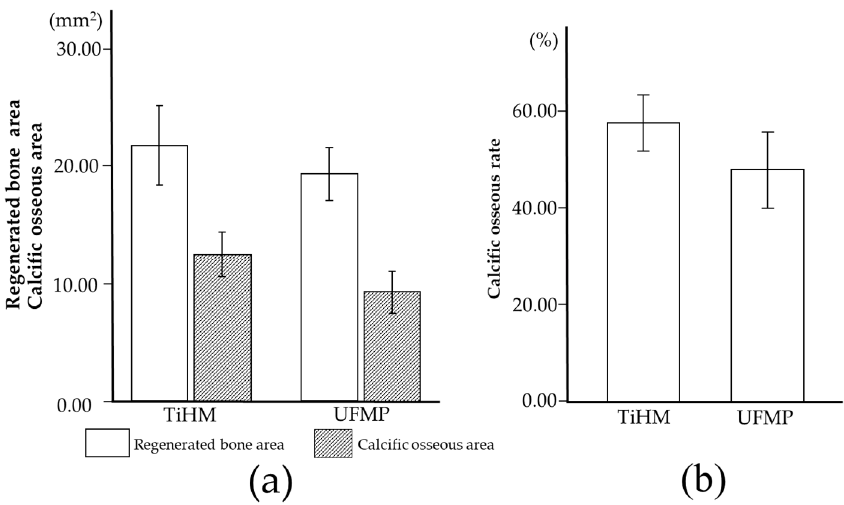
Figure 10. Histomorphometric analyses ( a ) RBA and COA. ( b ) COR. All data are presented as means ± SD.